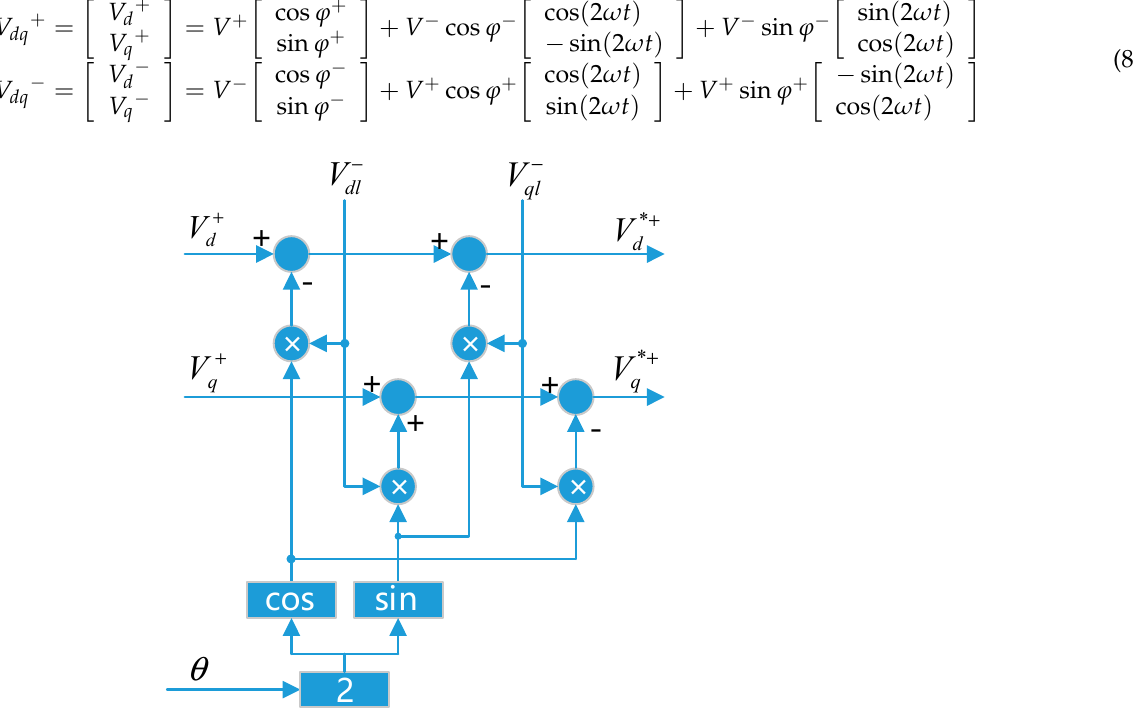
Figure 7. Schematic diagram of decoupling unit (U1).